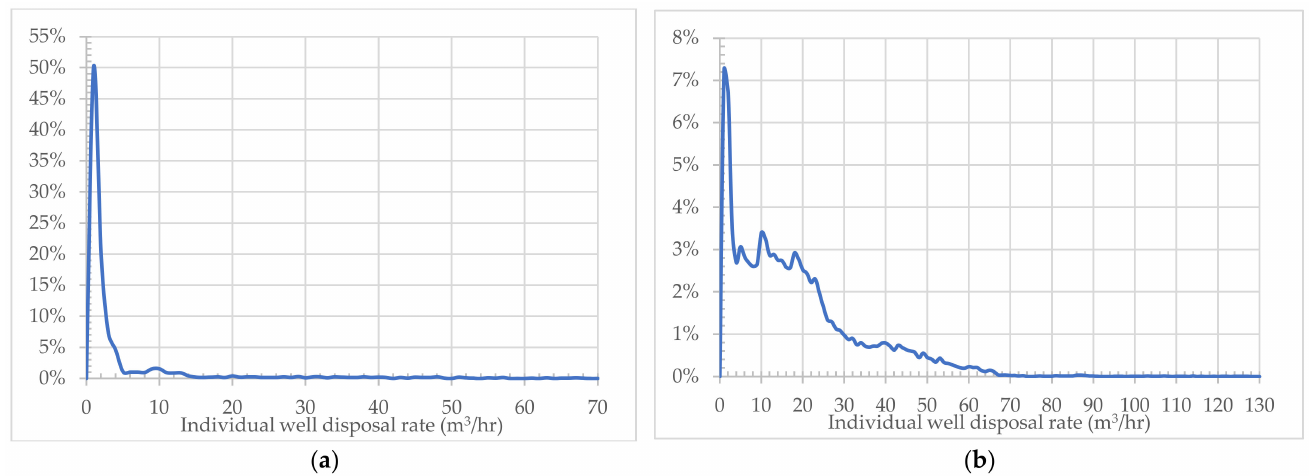
Figure A14. Historical per-well water injection rate ( X -axis) frequency ( Y -axis) distributions (January 1962–December 2022) in ( a ) the Gething Formation; ( b ) the Sunburst Formation.